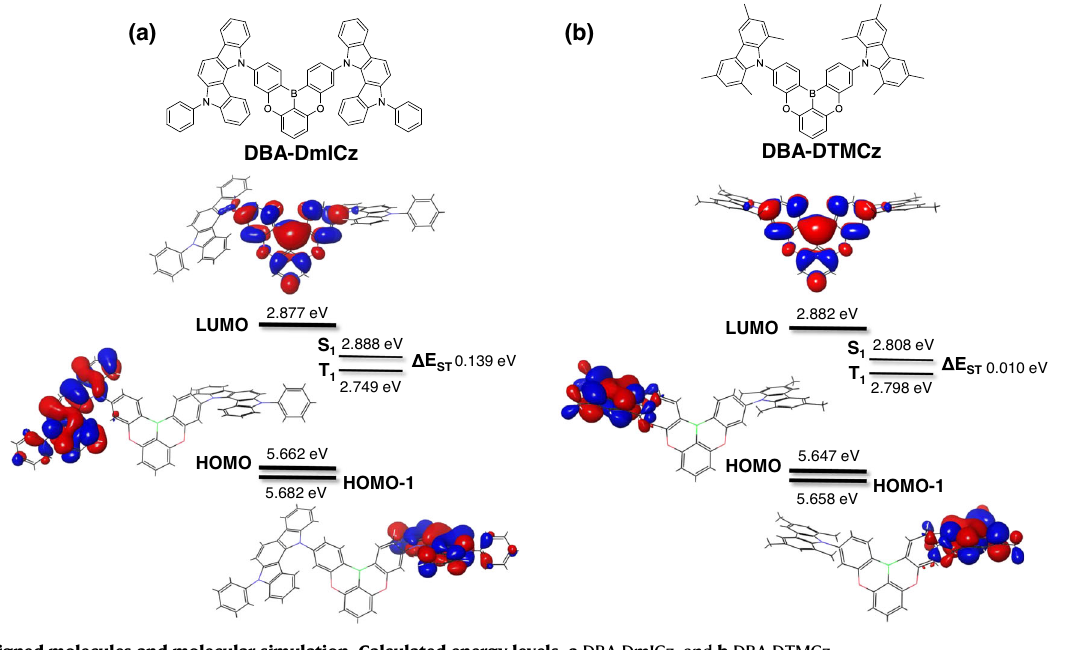
Fig. 1 | The designed molecules and molecular simulation. Calculated energy levels. a DBA-DmICz, and b DBA-DTMCz.